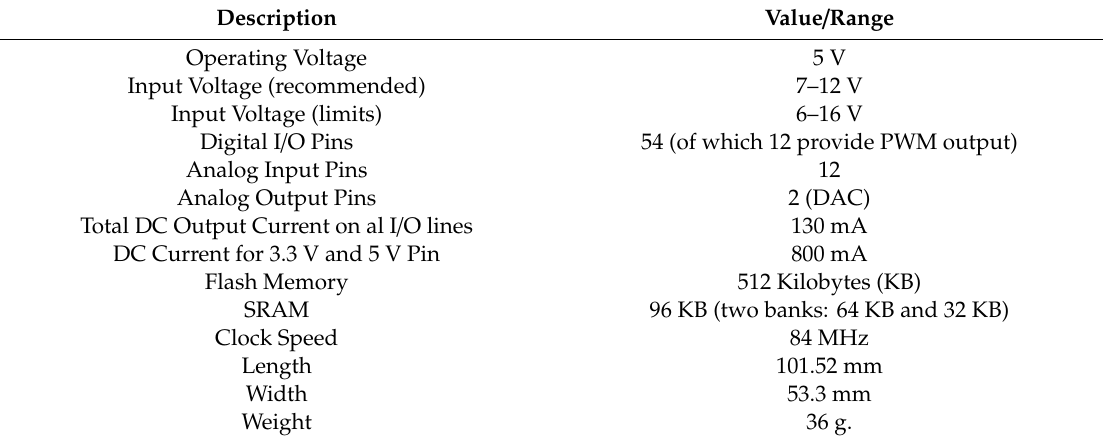
Table 1. Technical specifications of the Arduino Due